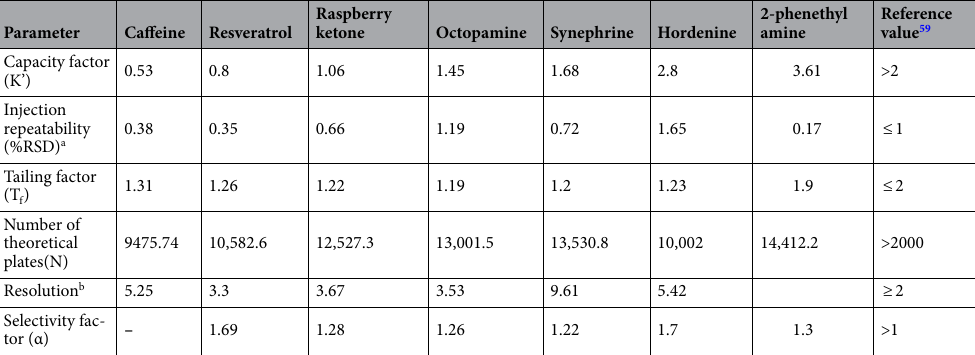
Table 2. System suitability parameters for the assay of the studied drugs using the proposed HPLC method. a Peak area of five replicates of standard solution. b USP Resolution calculated between a peak and its preceding peak.